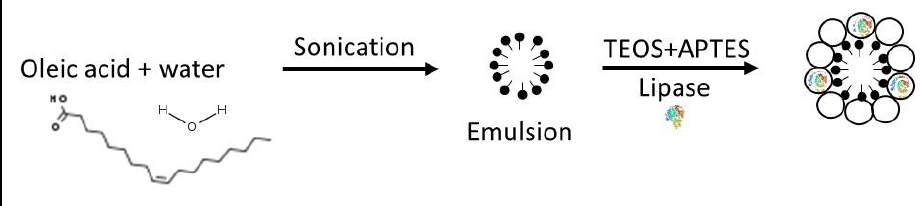
Figure 16. Scheme of lipase entrapment within mesoporous silica with an oleic acid core.